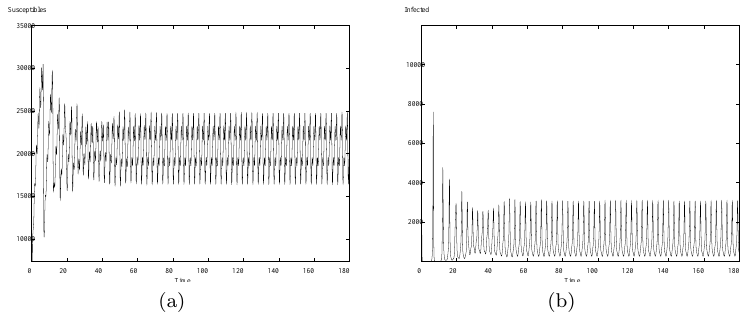
Figure 4. Three years periodic solution of our model and plots approximate results of ( a ) the susceptibles S ( t ) and ( b ) the infected I ( t ) against time in years, when R 0 > 1.